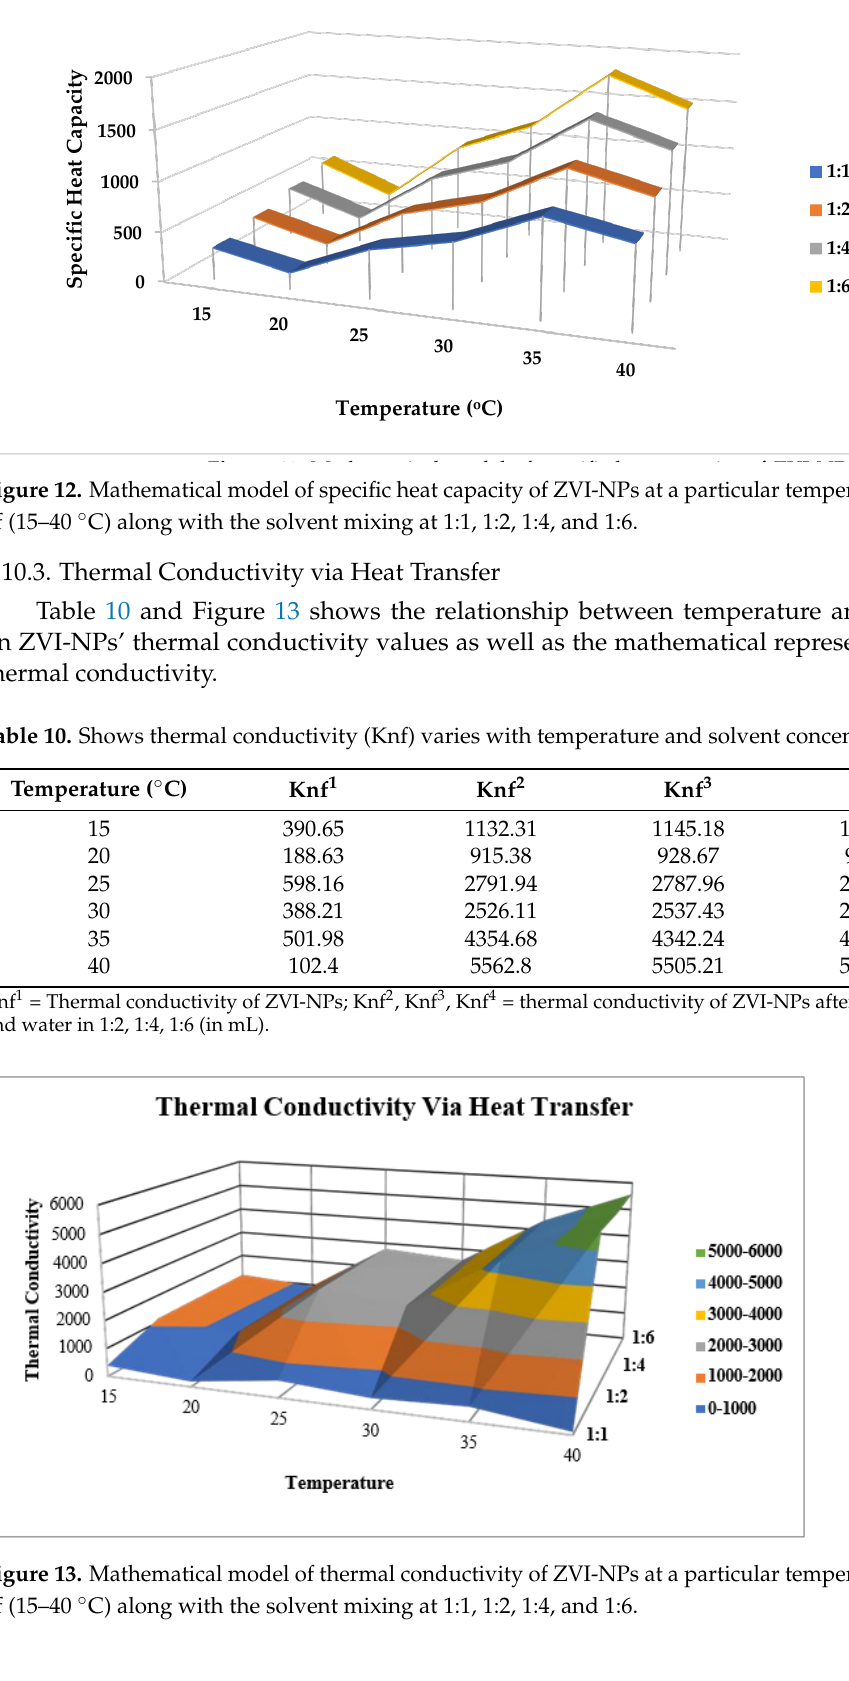
ρC p1 = Specific heat capacity of ZVI - NPs; ρC p 2 , ρC p3 , ρC p 4 = Specific heat of ZVI - NPS after mixing NPs and water in 1:2, 1:4, 1:6 (in mL).